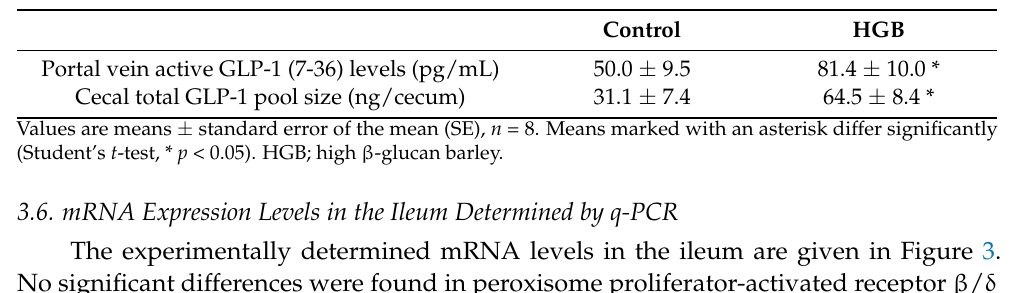
Table 6. Portal vein and cecal GLP-1